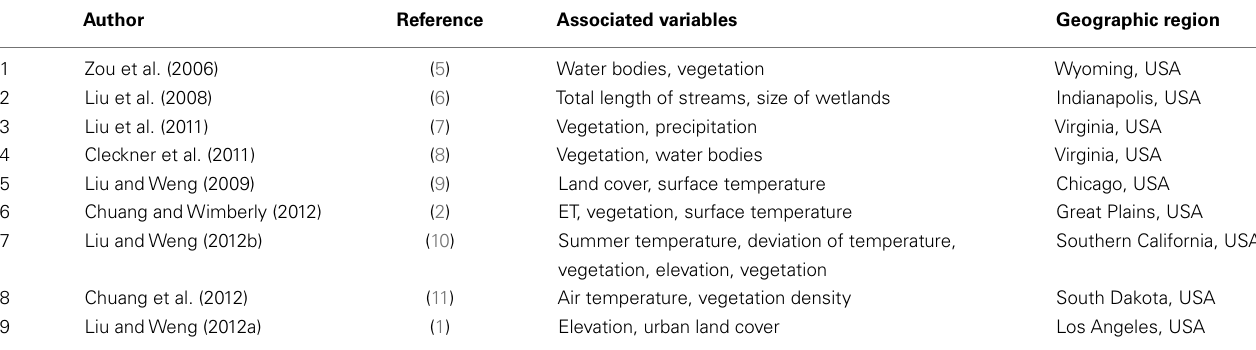
Table 1 | Summary of key available remote sensing basedWNV studies on hydroclimatic processes in the continental United States